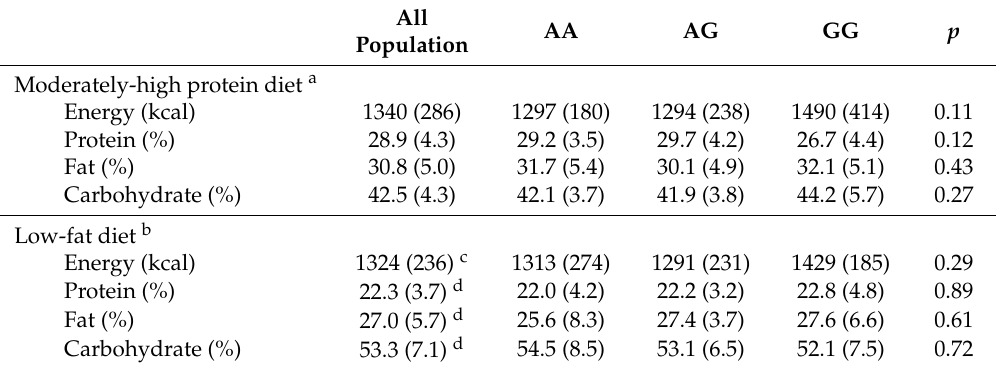
Table 3. Dietary intake by the ADCY3 rs10182181 genetic variant and diet group during the